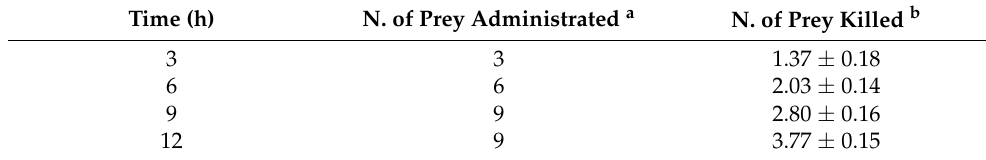
Table 2. Predation rate of Aeolothrips intermedius larvae on the onion pest Thrips tabaci adults. Time (h) N. of Prey Administrated a N. of Prey Killed b